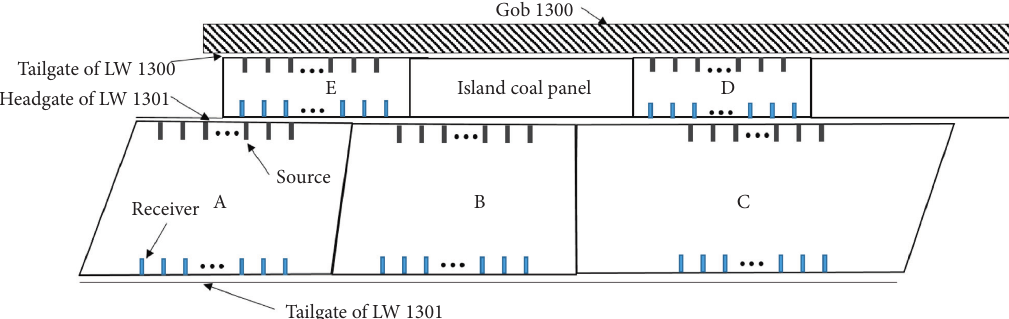
Figure 5: Deployment of the CT system in LW 1301 and the island coal pillar.